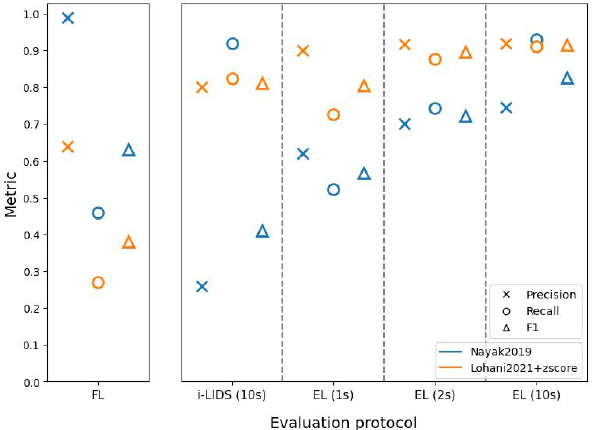
Figure 9. The results on view 1 of i-LIDS test set for two methods: [47] (in blue) and [6] with z-score (in orange). The abscissa represents three evaluation protocols: frame-level (FL) (on left subfigure), i-LIDS and edge-level (EL) (on right subfigure). i-LIDS is evaluated by default for 10 s whereas, for EL, we show results for 1, 2 and 10 s. The ordinate represents values of three metrics: precision, recall and F 1